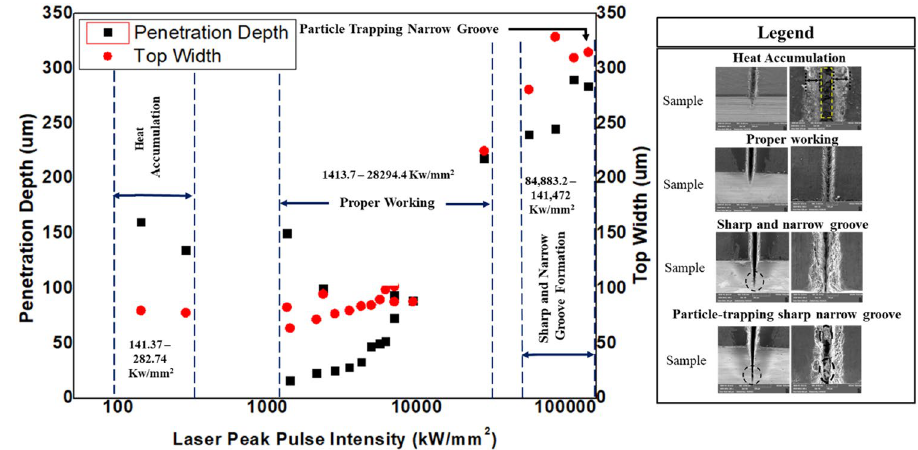
Figure 25. Mapping of laser interaction according of peak intensity.